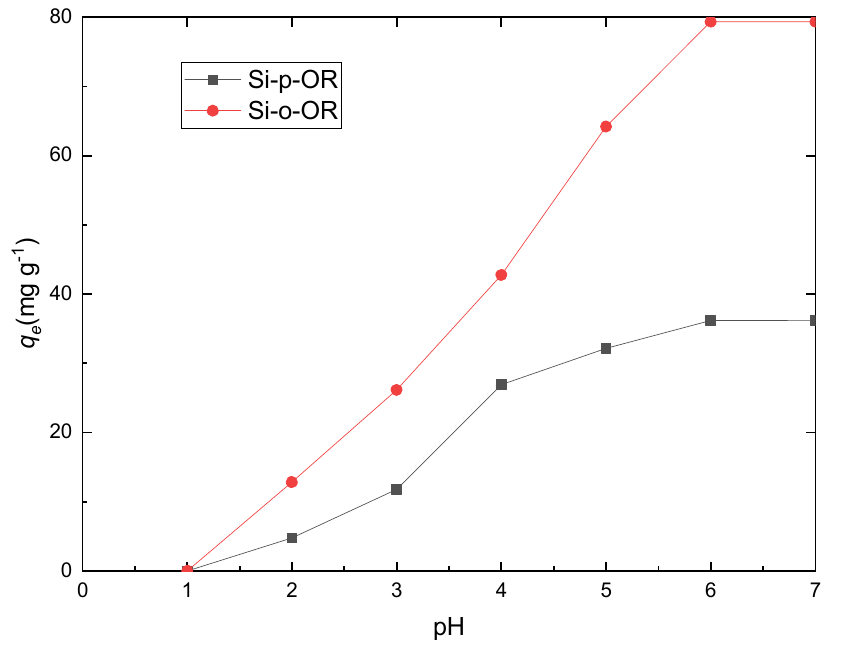
Figure 5. The effect of pH on the adsorption capacity of Si-o-OR and Si-p-OR towards Cu(II). Adsorption condition: V = 10 mL, m = 10 mg of adsorbent and optimum concentration = 120 mg L − 1 for 25 min at 25 °C.